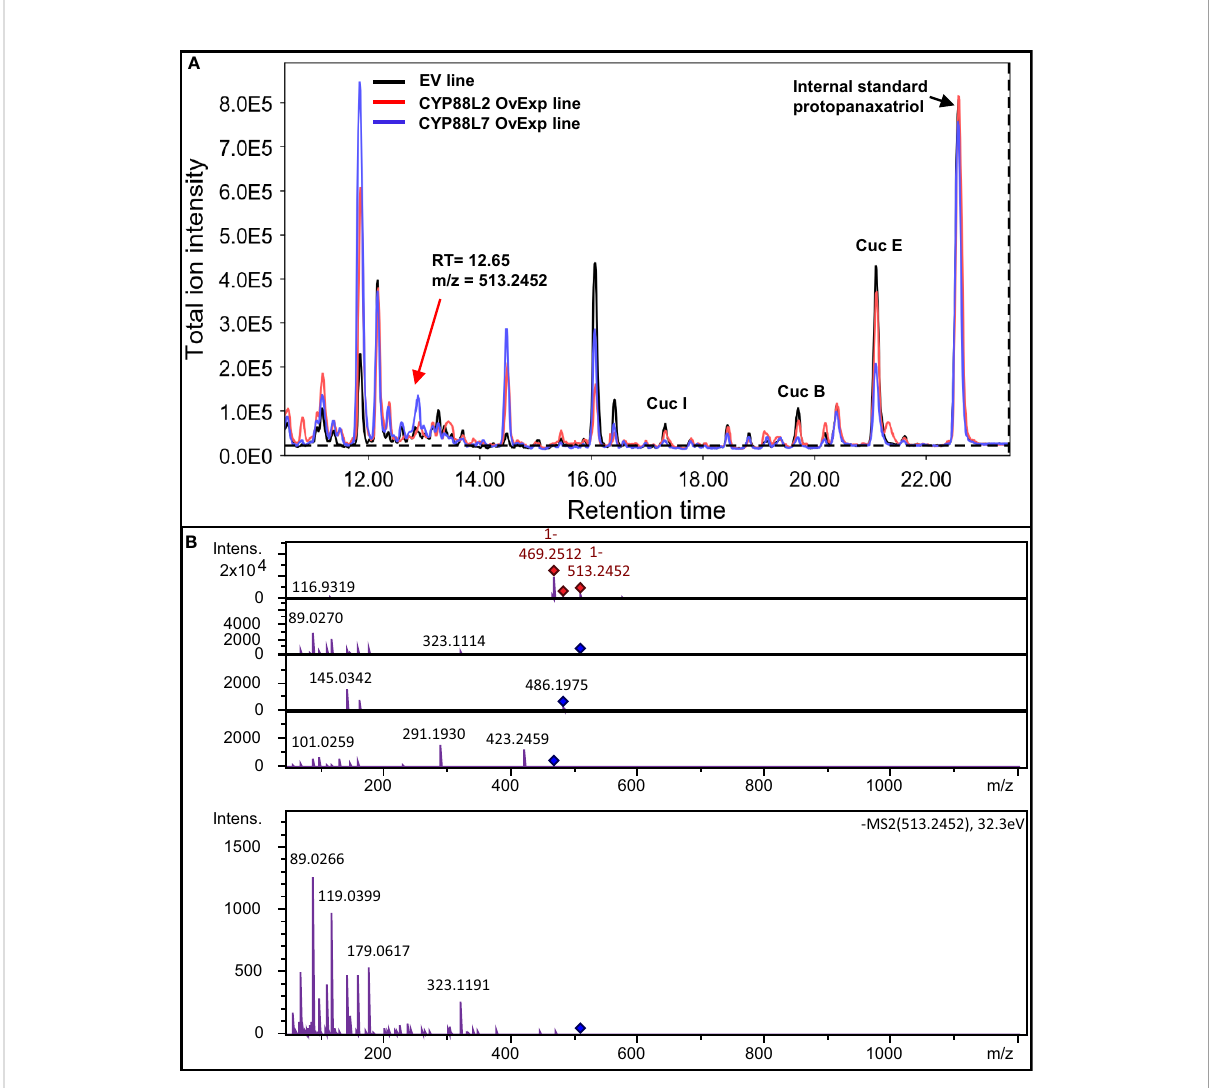
FIGURE 7 CYP88L2 and CYP88L7 appear to hydroxylate cucurbitacin intermediates in metabolically engineered Cucurbita pepo hairy roots. (A) Total ion chromatograms of HPLC-QToF analysis from Cucurbita pepo hairy roots empty vector, CYP88L2 overexpression and CYP88L7 overexpression lines. The new peak at 12,65 min is indicated with an arrow. (B) MS2 for the ion 513.2779 [M+COOH] - mass spectra at minute 12.65 Cucurbita pepo overexpressing CYP88L2 and CYP88L7 . Red diamonds represent ions detected in MS1 destined for fragmentation, while blue diamonds are these parental ion fragmented individually in the MS2